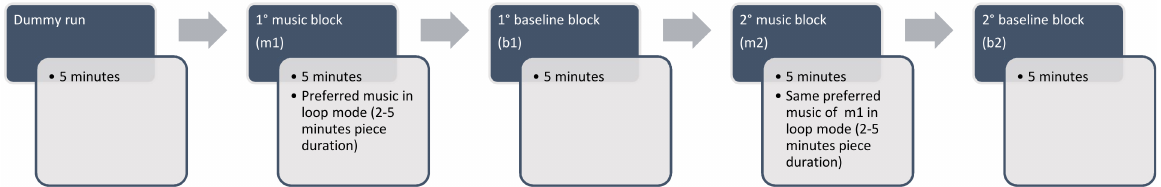
Figure 1. Illustration of the 5 subsequent blocks: baseline 1 (b1), music 1 (m1), baseline 2 (b2), music 2 (m2), baseline 3